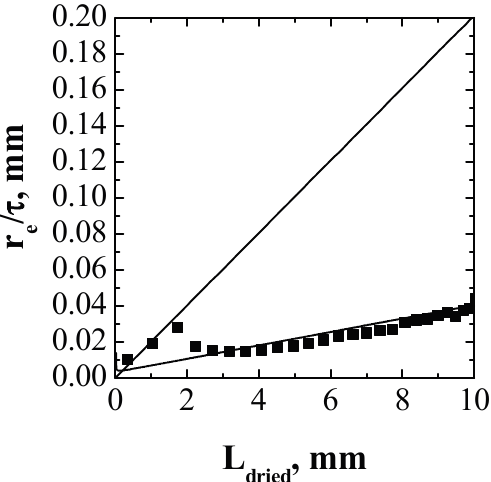
Figure 7. Values of r e / τ as a function of L dried calculated for the run shown in Figure 6 (symbols). The values obtained in type-I and type-III runs are shown for comparison